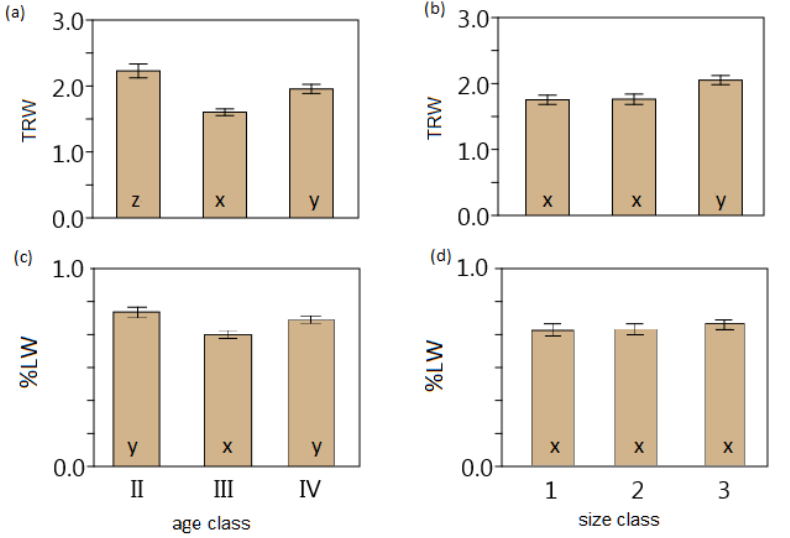
Figure 1. Mean (bar) ± standard error (whiskers) tree-ring width (TRW [mm]) and latewood proportion (%LW) in age ( a , c ) and tree size ( b , d ) classes. The same letter (x, y or z) indicates homogenous groups ( p < 0.05).